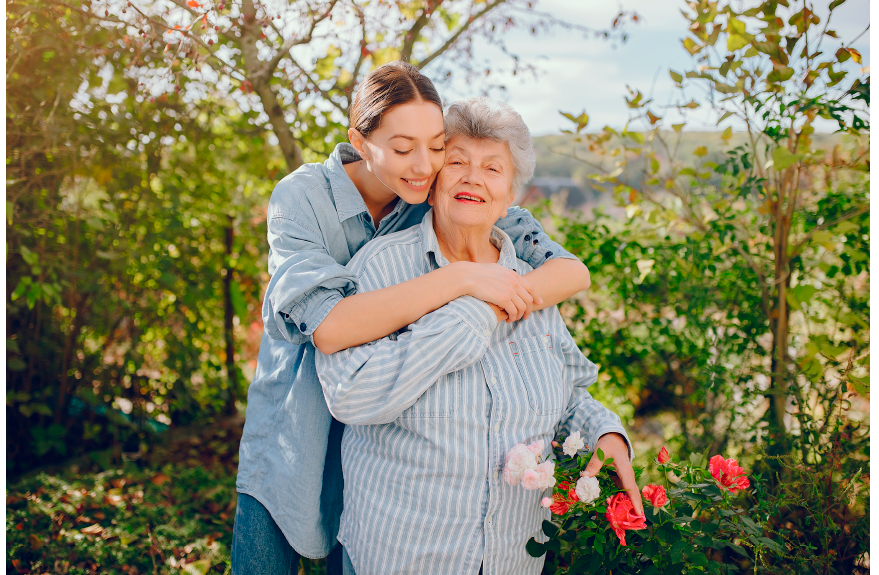
Figure 4. Older and younger women appear in natural space. Source, Freepik. https://www.freepik. es/foto-gratis/anciana-jardin-joven-nieta_7397387.htm (accessed on 20 November